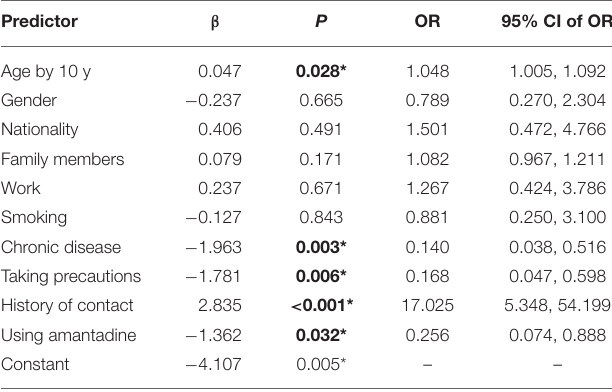
TABLE 5 | Odds ratio and its 95% confidence limits of COVID-19 predictors using forced entry multiple logistic regression model. Predictor